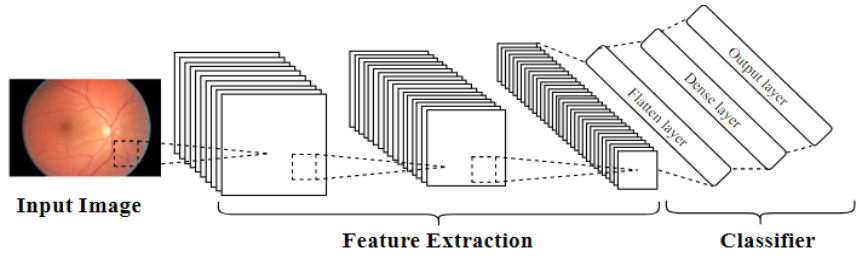
Figure 7. Convolutional neural network architecture.